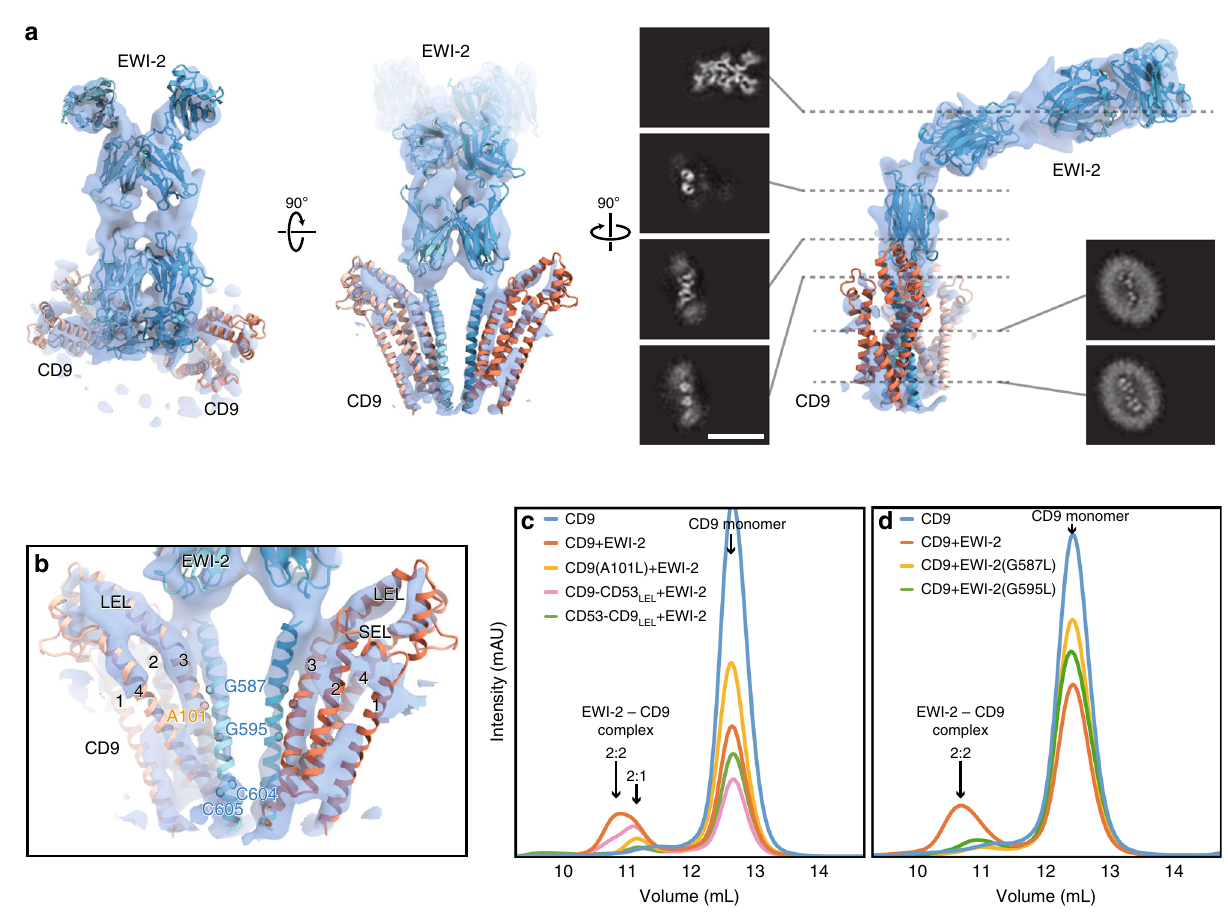
Fig. 4 Cryo-EM structure of CD9 in complex with EWI-2. a Cryo-EM density map of the Fab-CD9-EWI-2 complex. The density for the Fab fragment was somewhat disordered (Supplementary Fig. 6). Homology models of the Ig-like domains of EWI-2 were constructed with the PHYRE2 server 80 and roughly fi tted into the density. The TM helices and the two extracellular loops (SEL and LEL) of the CD9 crystal structure are separately fi tted into the density. The density for the detergent micelle is omitted for clarity. Black panels show sections of the density, demonstrating the C2 symmetry in the TM region and the proximal Ig-like domain. Scale bar, 100 Å. b Close-up view of the TM region. CD9 adopts a semi-open conformation with a slight rearrangement of the LEL, as compared to the crystal structure (Supplementary Fig. 6). The residues in the EWI-2 membrane-spanning region were modeled according to the mutant analyses in Fig. 2c, d. c , d Complex formation assays for CD9 mutants ( c ) and EWI-2 mutants ( d ). GFP-labeled CD9 and EWI-2 were co-expressed in HEK cells, and complex formation was analyzed by FSEC. The slight peak shift toward the smaller molecular weight indicates the complex formation with 2:1